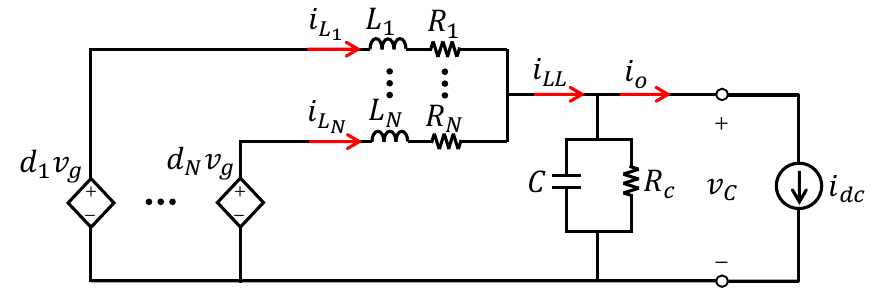
Figure 2. N-phase interleaved converter equivalent